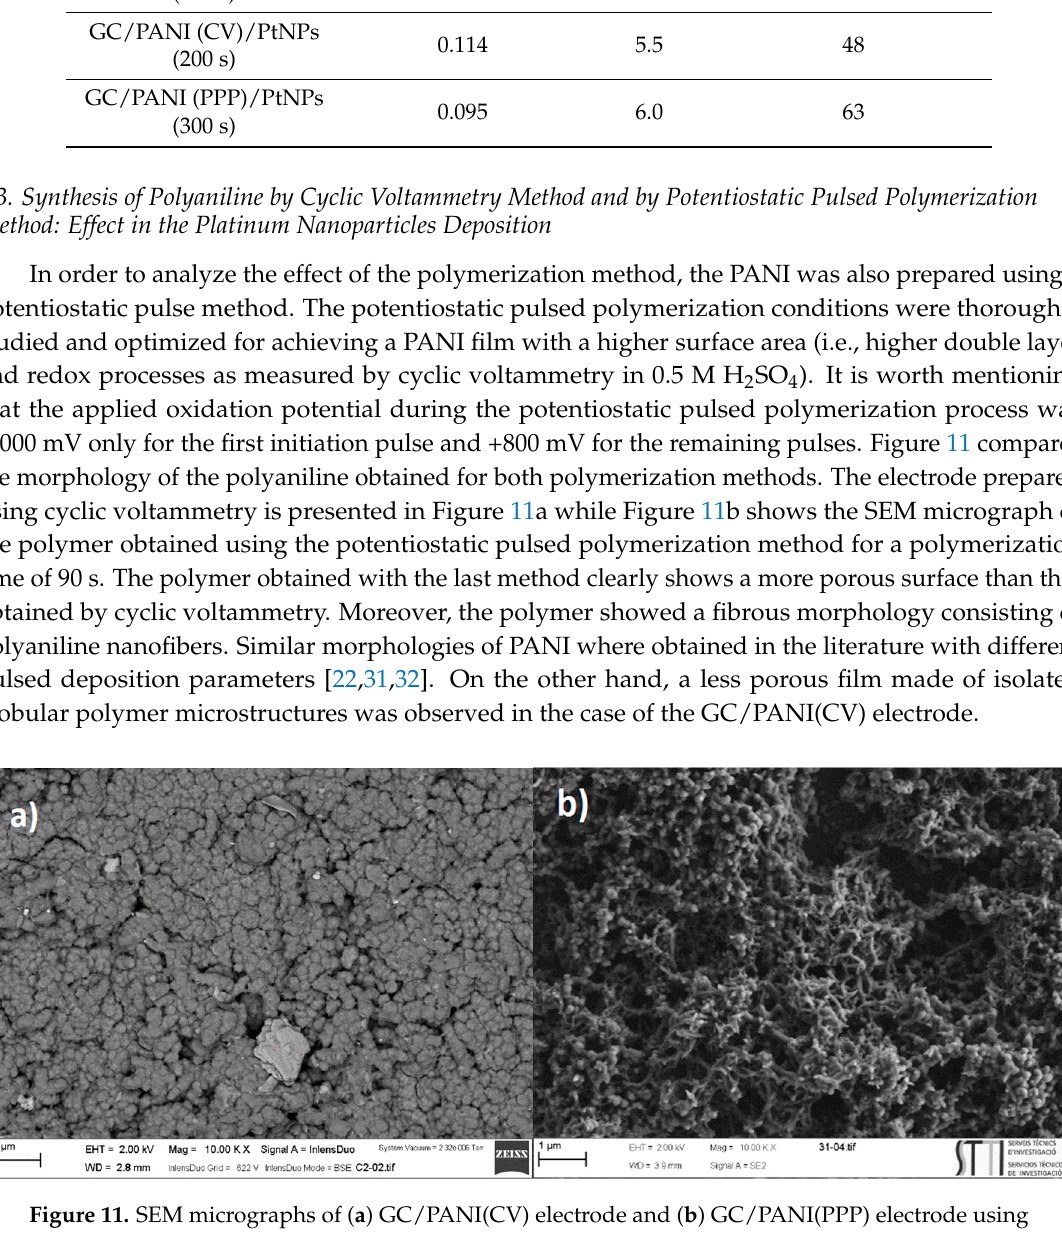
Figure 12. SEM micrographs of GC/PANI(PPP)/PtNPs using 25 s of polymerization time, with two magnifications: ( A ) 1 µ (a) and ( B ) 100 nm. The advantages of the potentiostatic pulsed polymerization method upon the activity of the resulting electrode has been explored for methanol oxidation. Figure 10a shows the obtained voltammogram of the GC/PANI(CV)/PtNPs electrode in a 2 M methanol +0.5 M H 2 SO 4 solution. It shows a relatively high oxidation peak at about 0.6 V, attributable to methanol oxidation catalyzed by platinum nanoparticles. The voltammogram during the oxidation of methanol for the electrode obtained by potentiostatic pulsed polymerization (GC/PANI(PPP)/PtNPs) is shown in Figure 10b. It can be observed that the catalytic activity was higher than the obtained using cyclic voltammetry for polymerization. The values of catalytic activity related to the amount of Pt are shown in Table 1. The ratio of the forward oxidation peak current (I f ) to the reverse peak current (I b ), is an index of the catalyst tolerance to the removal of poisoning species [54,55]. A higher I f /I b ratio indicates more effective removal of poisoning species on the catalyst surface and this ratio was 2.18 for the GC/PANI(PPP)/PtNPs electrode which was higher than for the GC/PANI(CV)/PtNPs electrode (1.54),